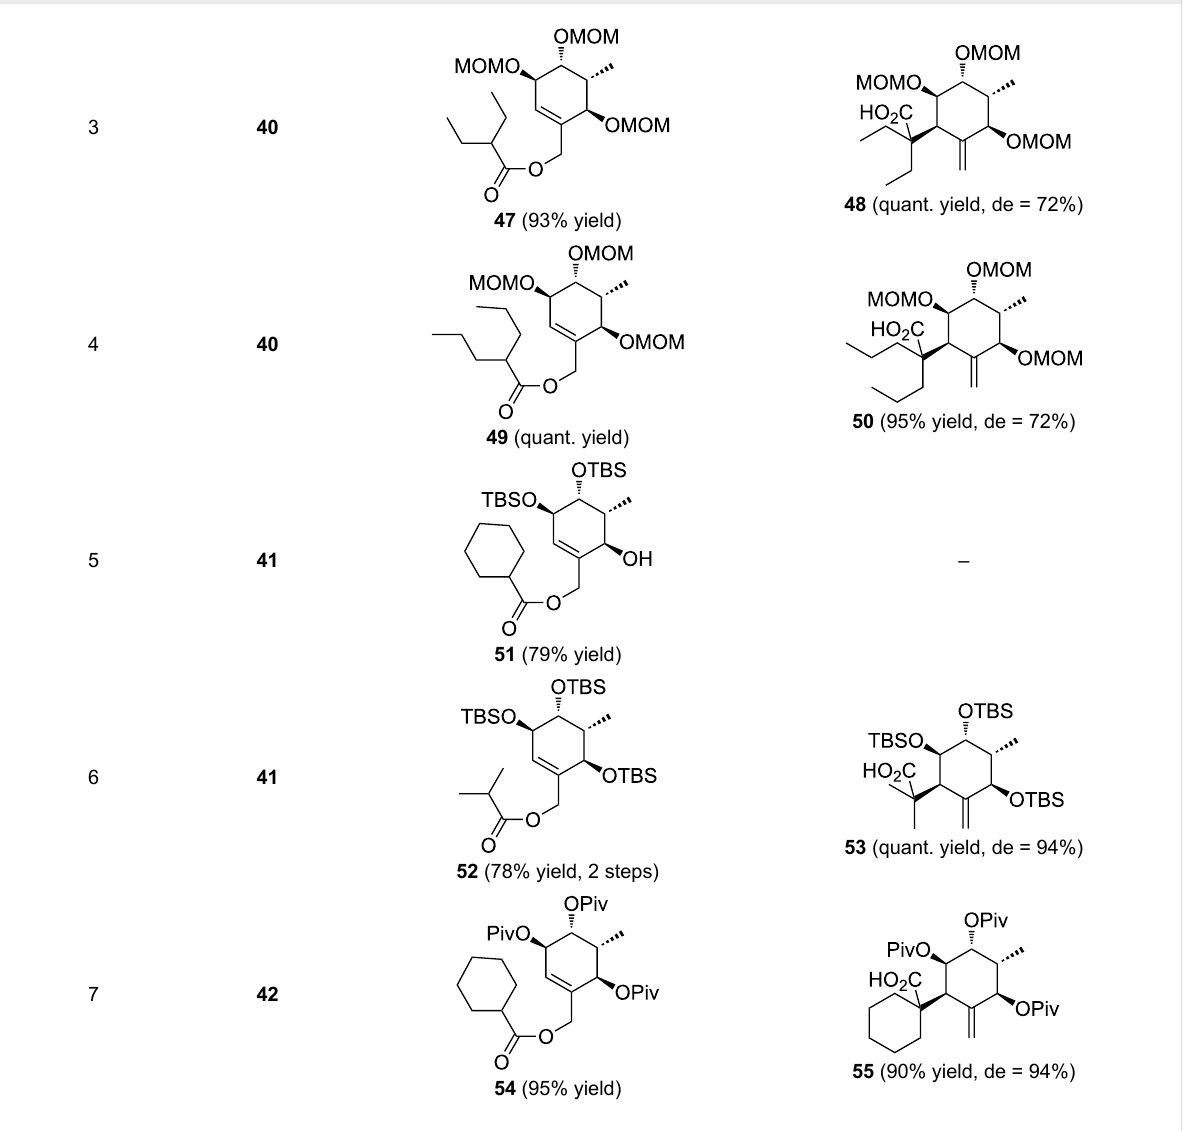
Table 2: Esterification of alcohols 40 , 41 and 42 and Ireland–Claisen rearrangement. Reagents and conditions: a) EDC·HCl, DMAP, carboxylic acid,